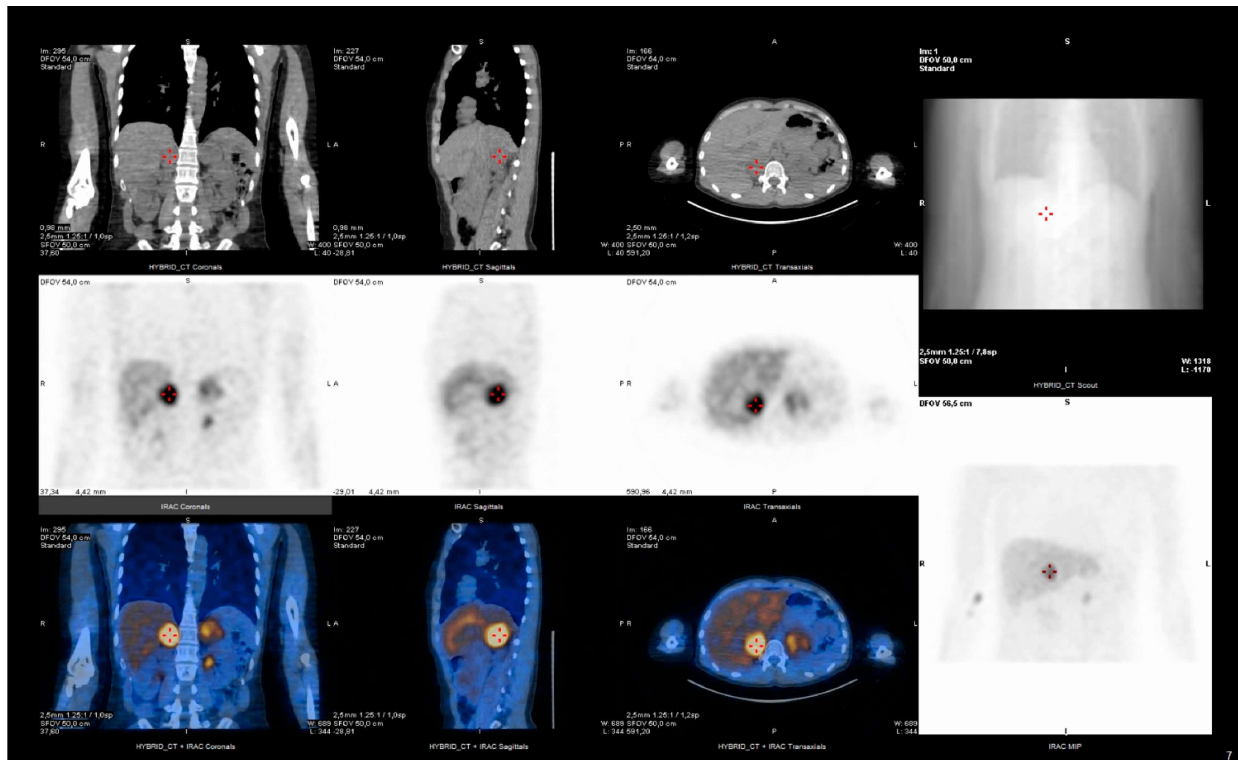
Figure 2: 123 I-MIBG SPECT/CT showing increased uptake of the tracer in both adrenal glands, with right predominance.